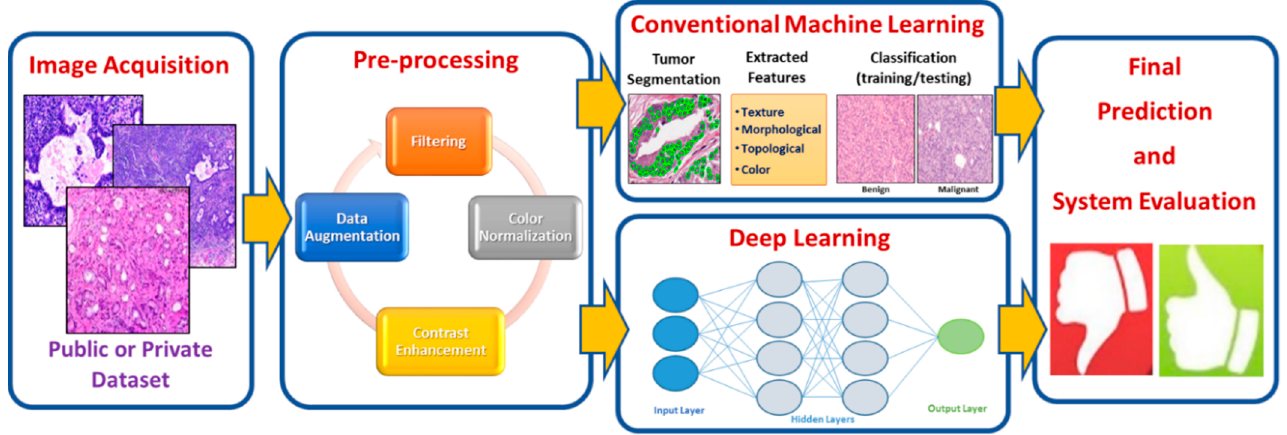
Figure 6. An illustrative block diagram of a typical prostate CAD System starting from the image acquisition until obtaining the final diagnosis.